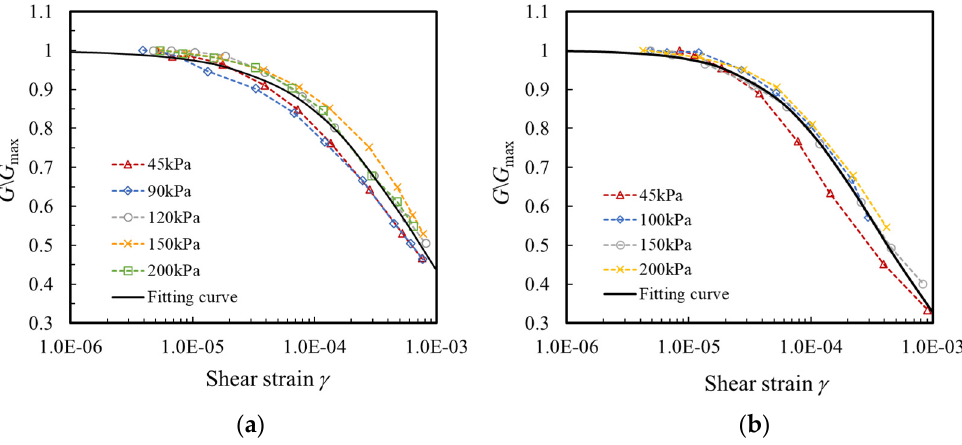
Figure 4. Variation of G / G max with γ of silty and medium sand: ( a ) G / G max - γ curve for silty sand; ( b ) G / G max - γ curve for medium sand.